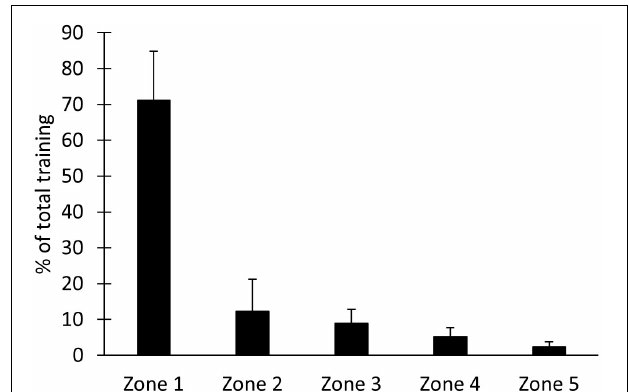
FIGURE 2 | Intensity distribution from heart rate monitored training throughout the study. Zone 1: < 75% of HR peak , zone 2: 75–85% HR peak , zone 3: 85–90% of HR peak , zone 4: 90–95% of HR peak , and zone 5: > 95% of HR peak .